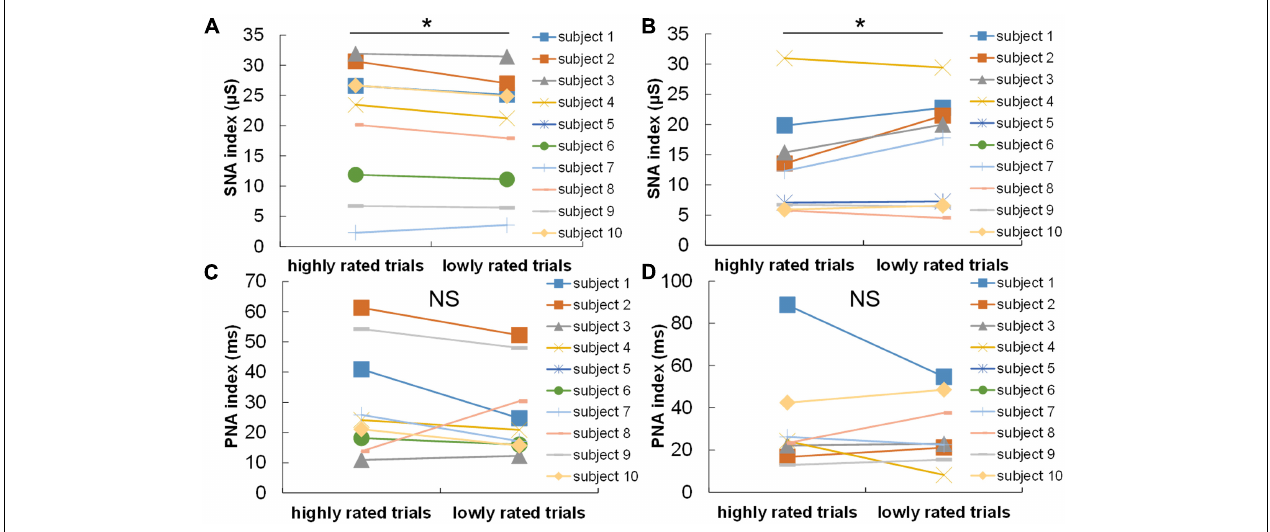
FIGURE 5 | Comparisons of autonomic nervous activities between highly lowly rated trials in terms of the subjective confidence in answers: comparison of (A) the answerer’s and (B) the supporter’s skin conductance between highly and lowly rated trials; and comparison of (C) the answerer’s and (D) the supporter’s RSA amplitudes of between highly and lowly rated trials. * p < 0.05. NS, not